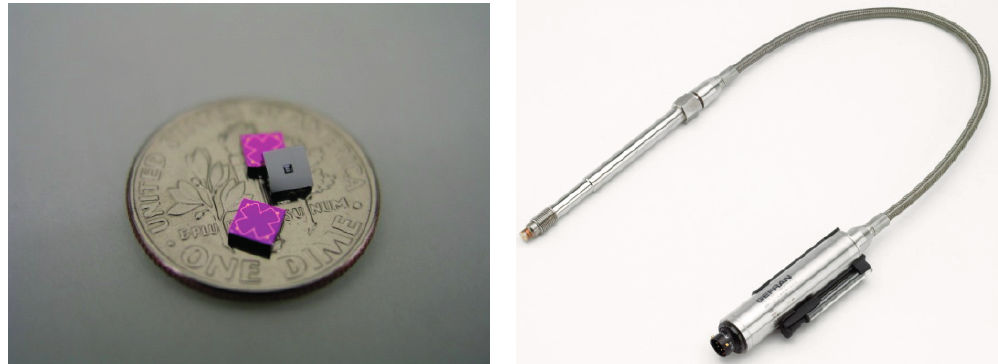
Figure 5. Fabricated SOI chips for floating concept. The chip size is 3.6 × 3.6 mm 2 ,